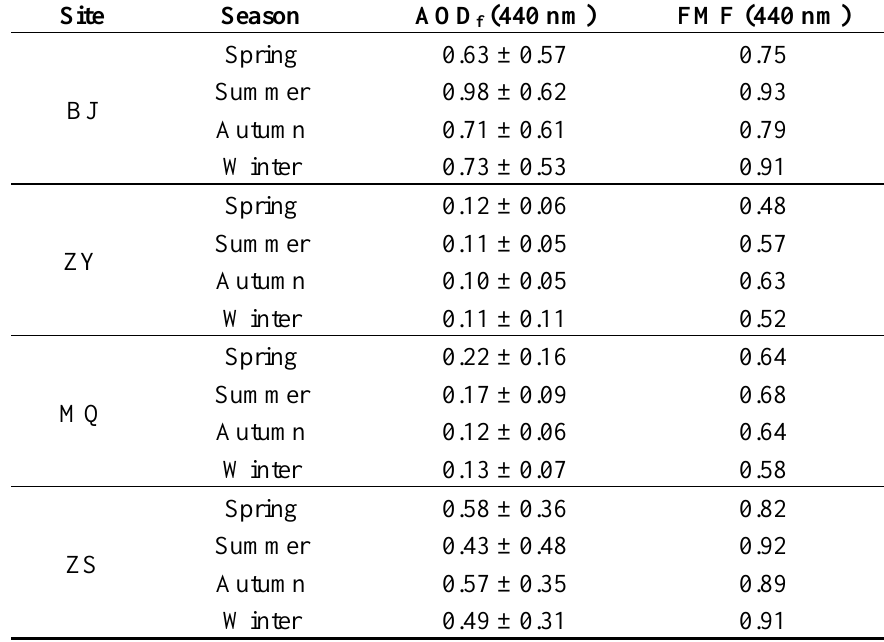
Figure 2. Seasonal average of aerosol optical depth of the four sites, ( a ) Beijing site; ( b ) Zhangye site; ( c ) Minqin site; ( d ) Zhoushan site. Error bar indicates the standard deviation of the average. Table 3. Fine mode aerosol optical depth (AOD f ) and fine mode fraction in optical depth (FMF) at 440 nm of the four sites in each